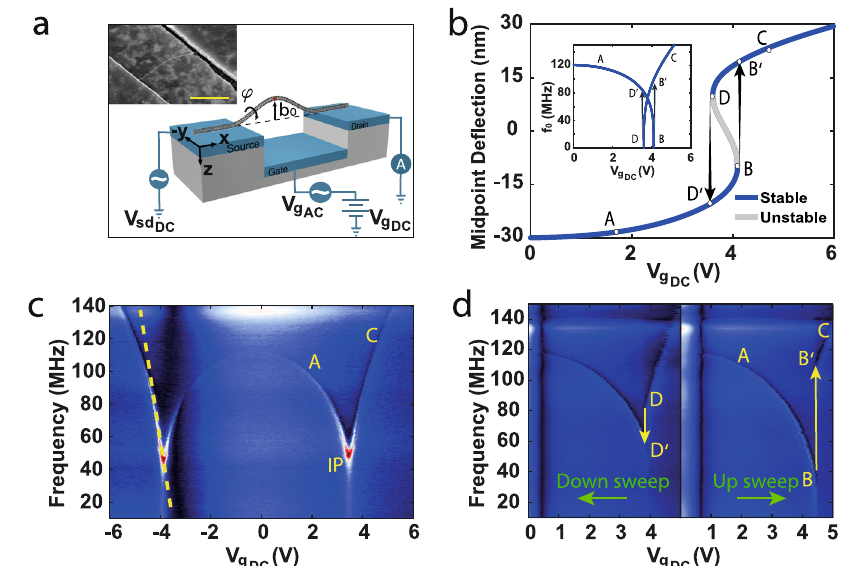
Fig. 1 | Suspended CNT-based bi-stable NEMS device. a Schematic layout of the device, coordinates system and experimental setup for the resonance frequency measurement.Notethatourcoordinatessystemissuchthatthepositivezdirection points downward. Inset: SEM image of a typical device, displaying initial upward buckling.Scalebar — 1 μ m. b Theoretical2Dmodelforthemidpointstaticde fl ection (red dot in a) as a function of the DC gate voltage. Our coordinates were chosen such that negative/positive values represent upward/downward curvature